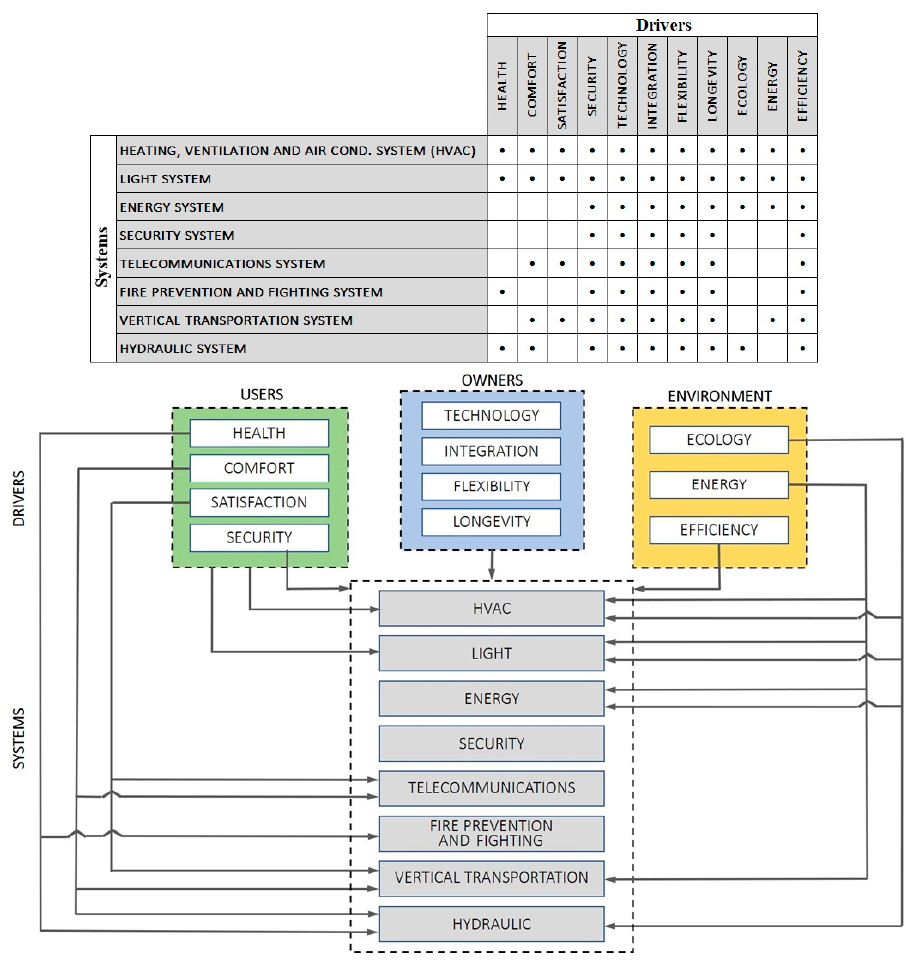
Figure 6. Relationships between drivers and systems.